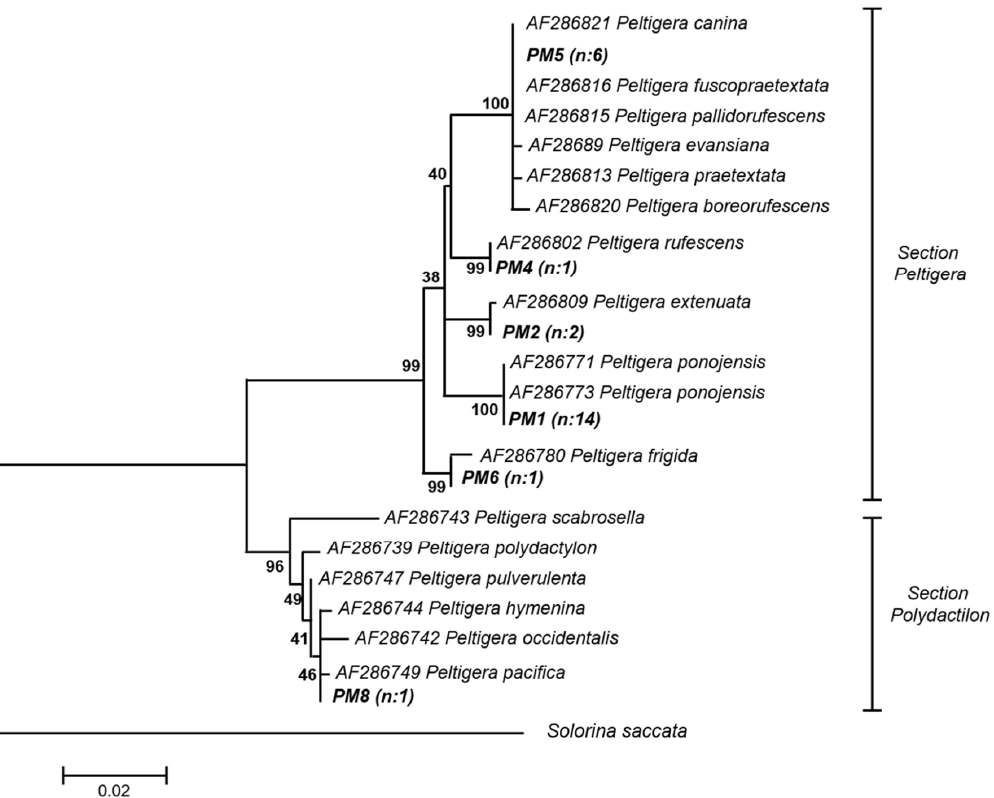
Figure A1. Phylogenetic tree of Peltigera operational taxonomic units (OTUs) by Bayesian inference. Bootstrap support values are indicated at the nodes and the bar indicates the genetic distance. The mycobionts from this study, named as PM followed by a number, are shown in bold. The number of specimens per haplotype is shown in parentheses. The division of the species into sections corresponds to Zúñiga et al. [23]. Solorina saccata (accession number DQ973044) sequence was used as outgroup.